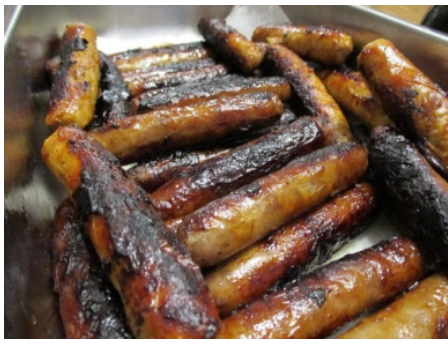
Figure 4. Grace, Figure 4. Grace, 15.